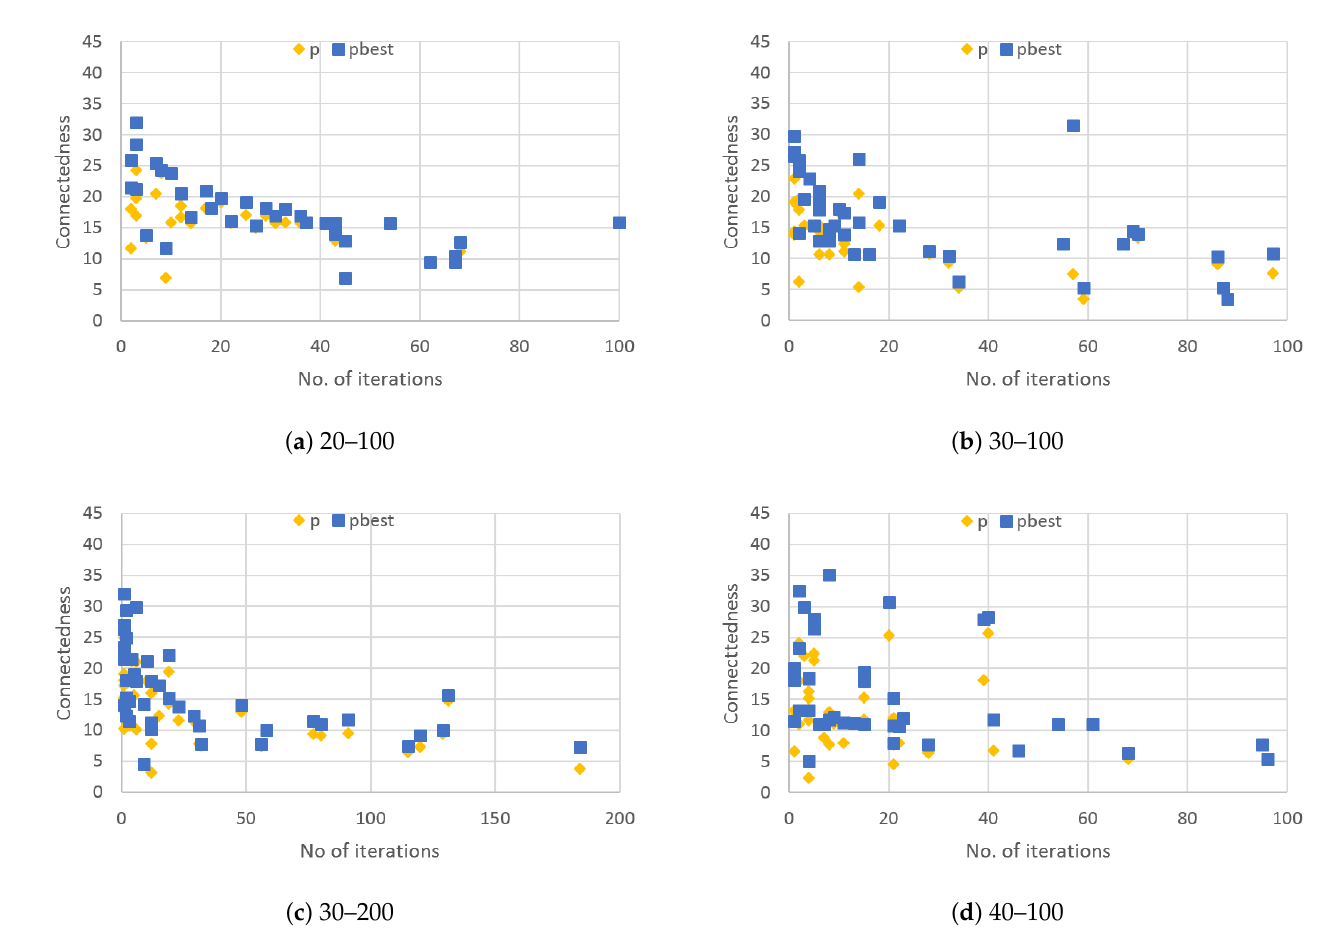
Figure 3. Convergence plot of particles p and their pbest where p dominates pbest in line 9 in Algorithm 1 on Appendicitis dataset using different swarm size (s) and maximum iterations (i), labeled as s-i in ( a – d